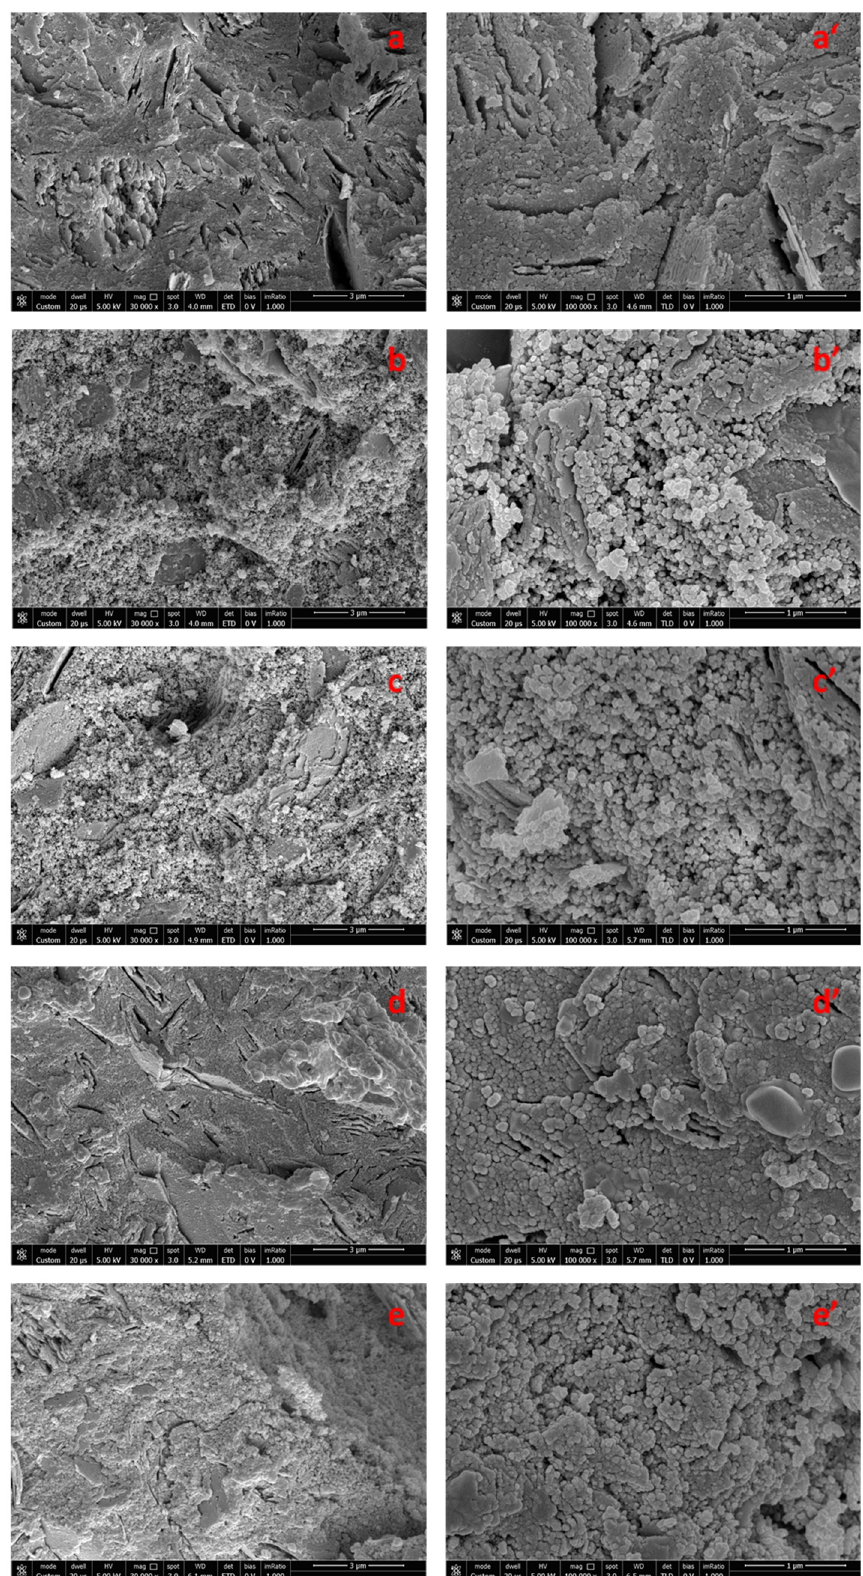
Figure 4. Scanning electron microscope (SEM) micrographs at 30,000 × and 100,000 × magnifications of freshly obtained fractured surfaces of: neat geopolymer MK ( a , a’ ), MK-PVAc-5 ( b , b’ ), MK- PVAc- 10 ( c , c’ ), MK-PDMS-5 ( d , d’ ), and MK-PDMS-10 ( e , e’ ) after thermal treatment at 450 °C for 2 h in air.